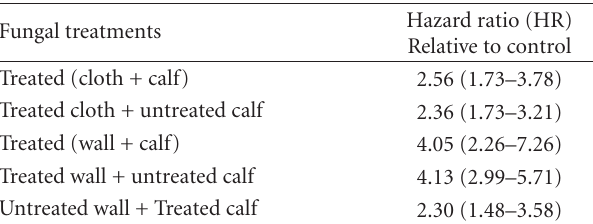
Table 1: Hazard ratio of An. arabiensis after exposure on di ff erent fungal-treated surfaces and cattle. The numbers in brackets are 95% confidence intervals. The treatments are abbreviated as TCTca for (treated cloth roof + calf), TCUca for treated cloth + untreated calf, TwTca for (treated mud wall + treated calf), TwUca for (treated mud wall + untreated calf), and UwTca for (untreated mud wall + treated